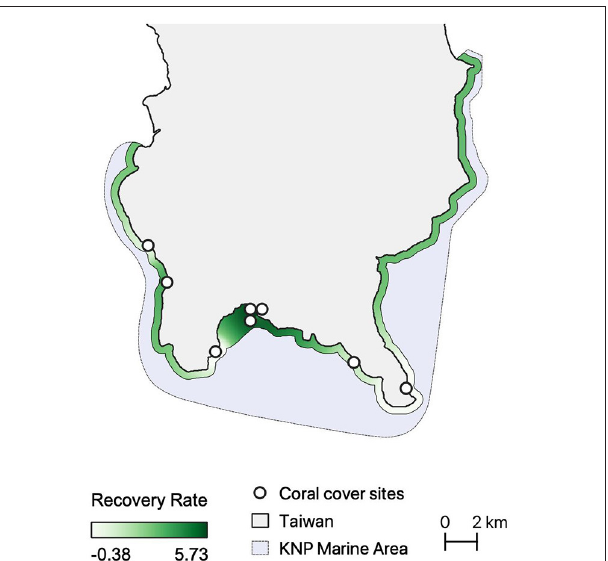
FIGURE 3 | Spatial Interpolation of coral cover recovery rate (2010 vs. 2016) along a 500-m coastal buffer. The white points indicate the sites monitored by the Long-Term Ecological Research (LTER) project in Kenting National